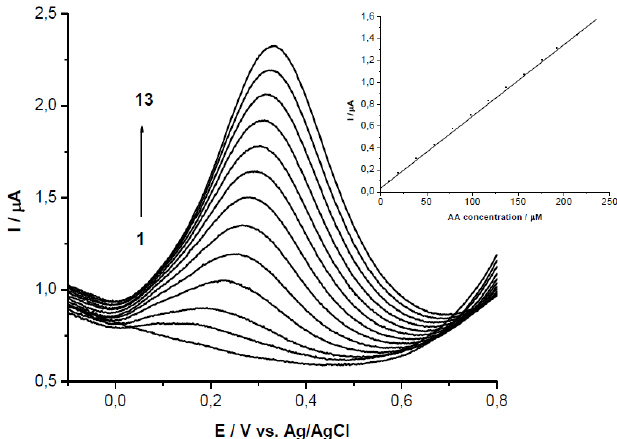
Figure 10. SWVs for AA solution with different concentrations: (1) 0 μM; (2) 9.99 μM; (3) 19.96 μM; (4) 39.84 μM; (5) 59.64 μM; (6) 79.36 μM; (7) 99 μM; (8) 118.5 μM; (9) 138.06 μM; (10) 157.48 μM; (11) 176.81 μM; (12) 193.07 μM; (13) 215.26 μM (Inset: calibration